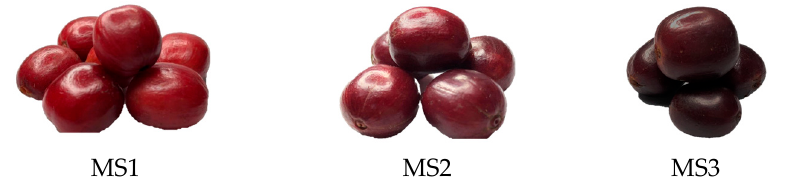
Figure 1. Maturity stages of coffee fruits.